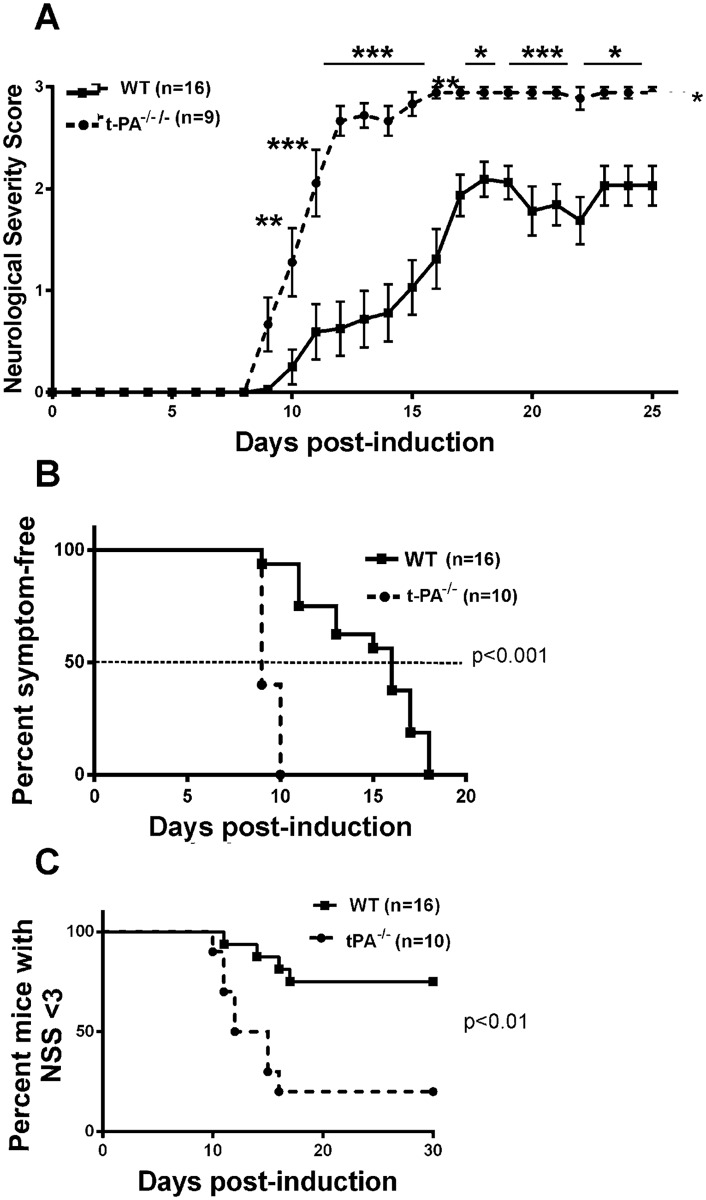
t-PA-/- mice develop a more severe form of EAE.(A): Wild-type (WT, n = 16) and t-PA-/- mice (n = 9) were immunized with the MOG35-55 peptide to induce EAE. Disease severity was evaluated daily using a neurological severity score scale (see methods). As shown, t-PA-/- mice developed EAE symptoms at a greater rate than WT mice. Data presented as Mean±SEM. *p<0.05; **p<0.01; ***p<0.001. (2-way ANOVA). The data from (A) was also graphed in terms of percentage symptom-free (B) and percent survival (C) post-immunization. For C, percent survival was based on mice with a neurological severity score (NSS) less than 3. As shown, a greater proportion of t-PA-/- mice displayed less symptom-free survival (p<0.001) and significantly reduced survival rates (p<0.01) following EAE compared to wild-type control mice. (Gehan-Breslow-Wilcoxin test).